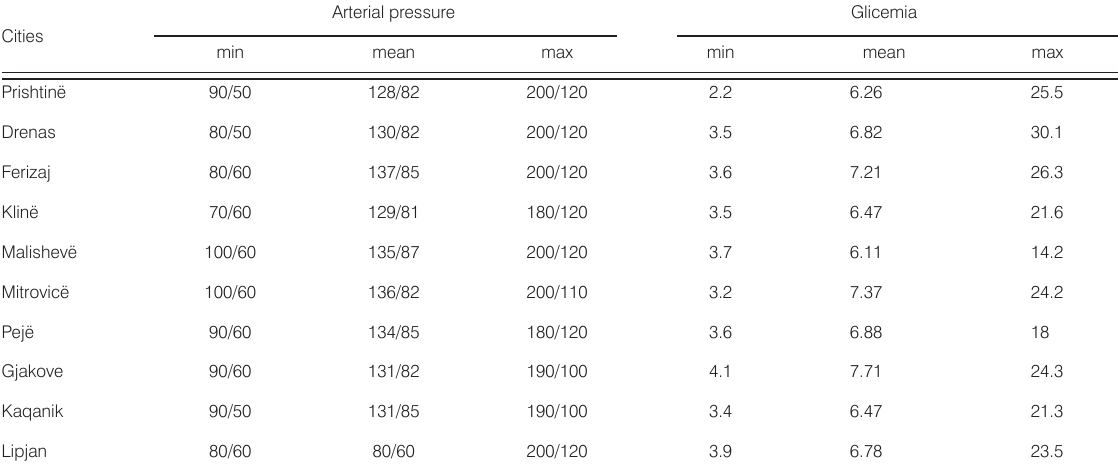
Table 3. Descriptive data for arterial pressure and glicemia as regards cities of Kosovo in